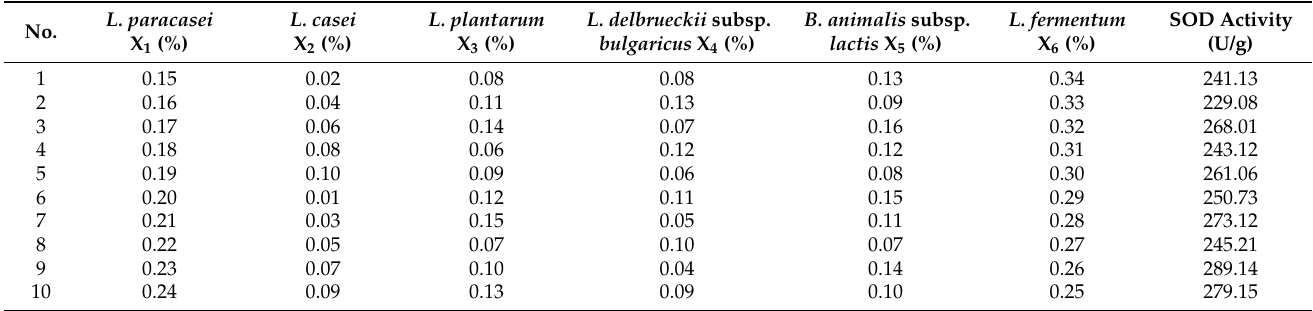
Table 6. Results of uniform design experiments.